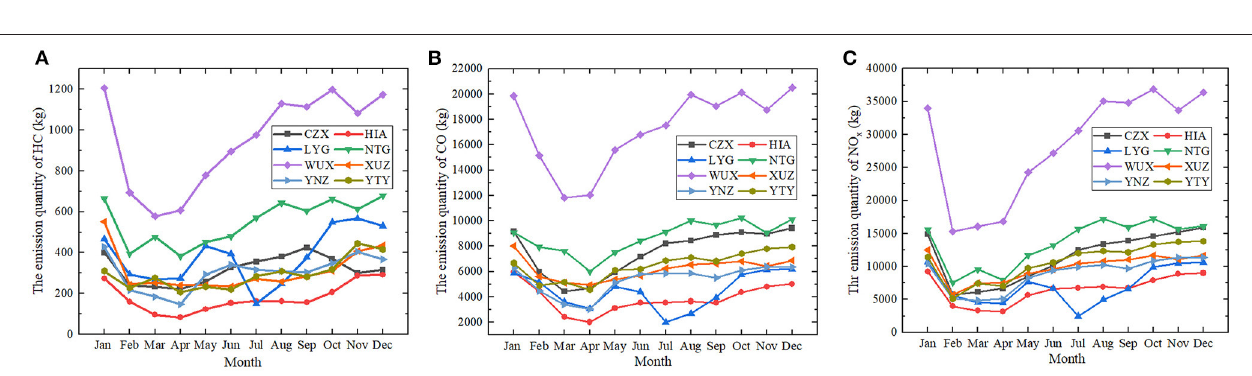
FIGURE 3 | The monthly variation of the air pollutants at airports in the 3 capital cities (i.e., Nanjing, Hangzhou, Hefei), 2020. (A) The emission quantity of HC in kilograms (B) The emission quantity of CO in kilograms (C) The emission quantity of NO x in kilograms. HFE, Hefei Xinqiao Airport; NKG, Nanjing Lukou Airport; HGH, Hangzhou Xiaoshan Airport.